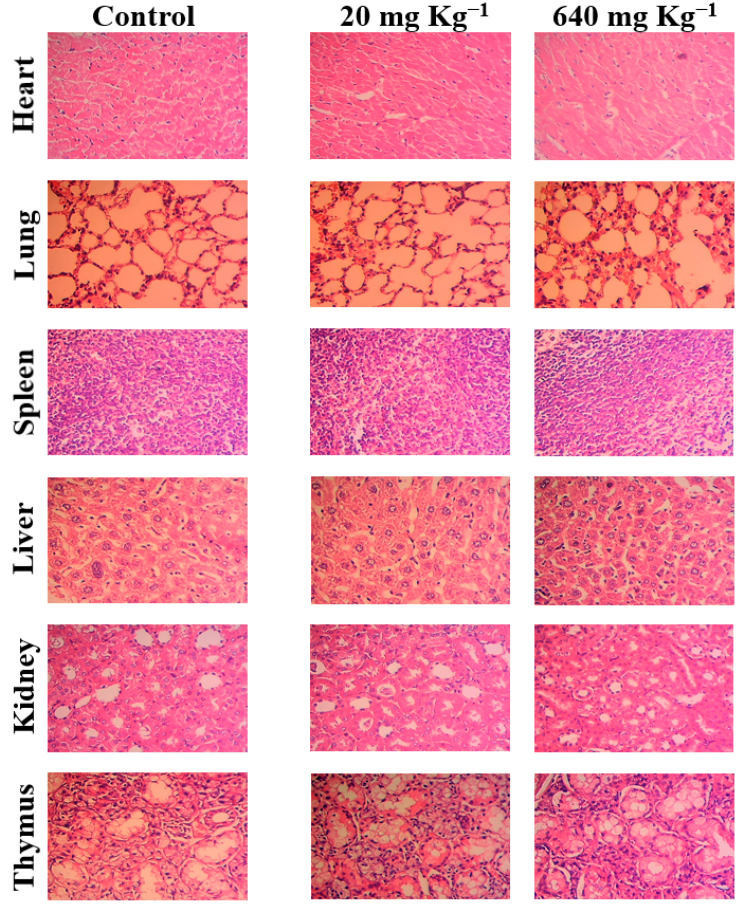
Figure 13. Histological images for heart, lung, liver, spleen, kidney, and thymus of mice orally treated with different doses of GAL/ β -CD (20 mg kg − 1 , 640 mg kg − 1 ), (magnification power: 40×). The treated groups’ kidney tissues were similar to those of the control group because the glomerular and renal tubular epithelial cells did not suffer from atrophy. While lung tissue slices revealed no significant congestion of pulmonary capillaries with erythrocytes, isolated intra-alveolar bleeding, or mononuclear cell infiltration, no other alterations in lung micromorphology were noted (e.g., alveolar septal thickening or hypercellularity). The cardiac muscle, i.e., the myocardium, is made up of cross-striated muscle cells called cardiomyocytes, with one central nucleus. Intercalated discs, which are specialized junc- tions between cardiac cells, were seen in cardiac muscles with no enhanced cytoplasmic vacuolization or myofibrillar loss. As a result, animals exposed to GAL/ β -CD showed no histopathological abnormalities in their liver, spleen, lung, kidney, heart, and thymus, indicating that employing GAL/ β -CD for in vivo applications is safe. At the